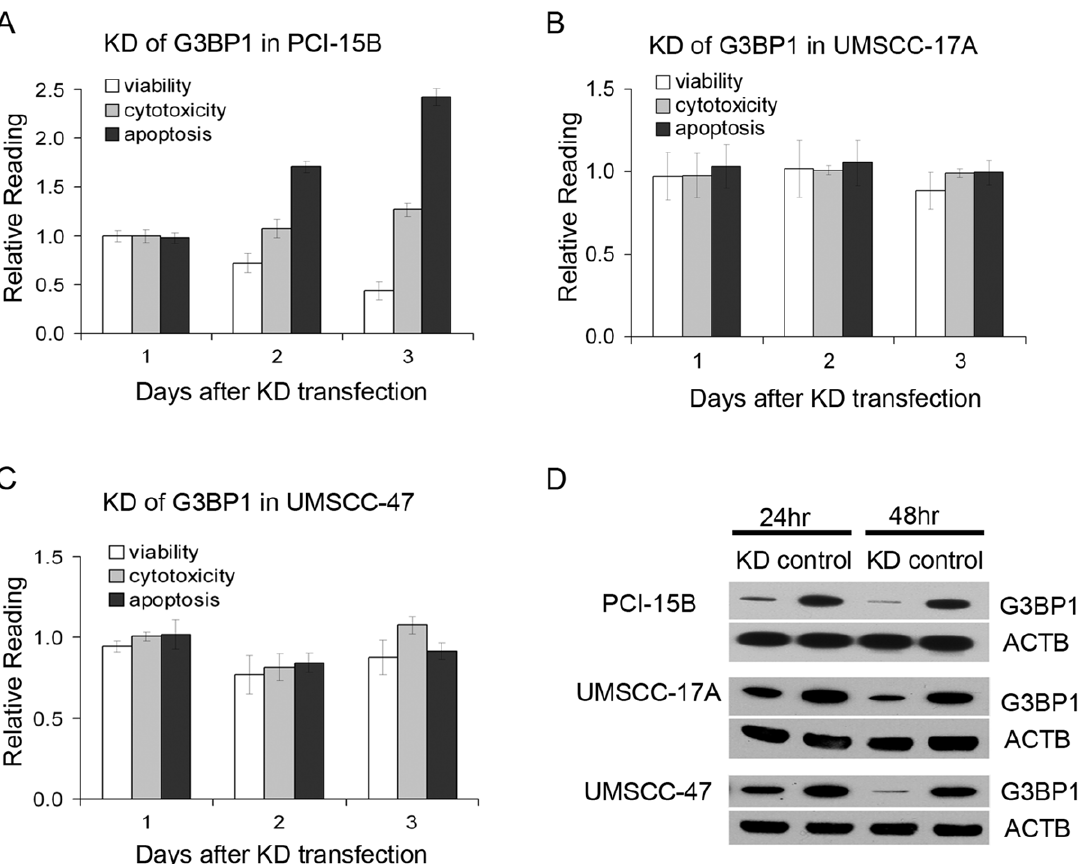
Figure 4. Effects of G3BP1 knockdown in OSCC. Cell viability, cytotoxicity, and apoptosis in OSCC cell lines PCI-15B (A), UM-SCC-17A (B), UM- SCC-47 (C) after the KD of G3BP1. The results are presented as relative to the reading in control wells that are transfected with negative control siRNA. Error bar indicates standard deviation of the readings in three repeat wells; (D) Confirmation of the KD of G3BP1 in these cell lines with western blot. Beta-actin (ACTB) is used as a loading control.